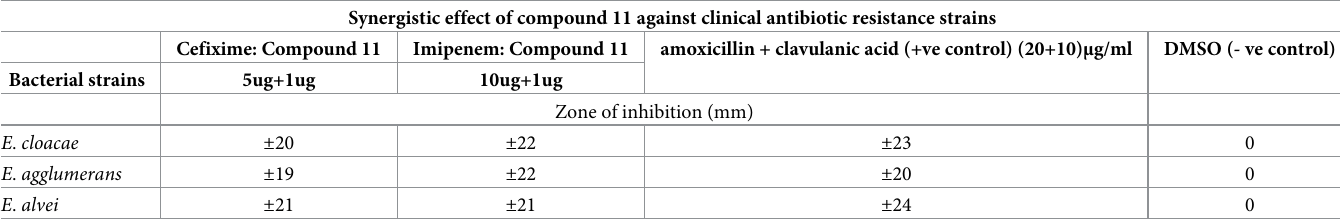
Table 4. Synergistic effect of compound 11 with different concentration against clinical isolates.